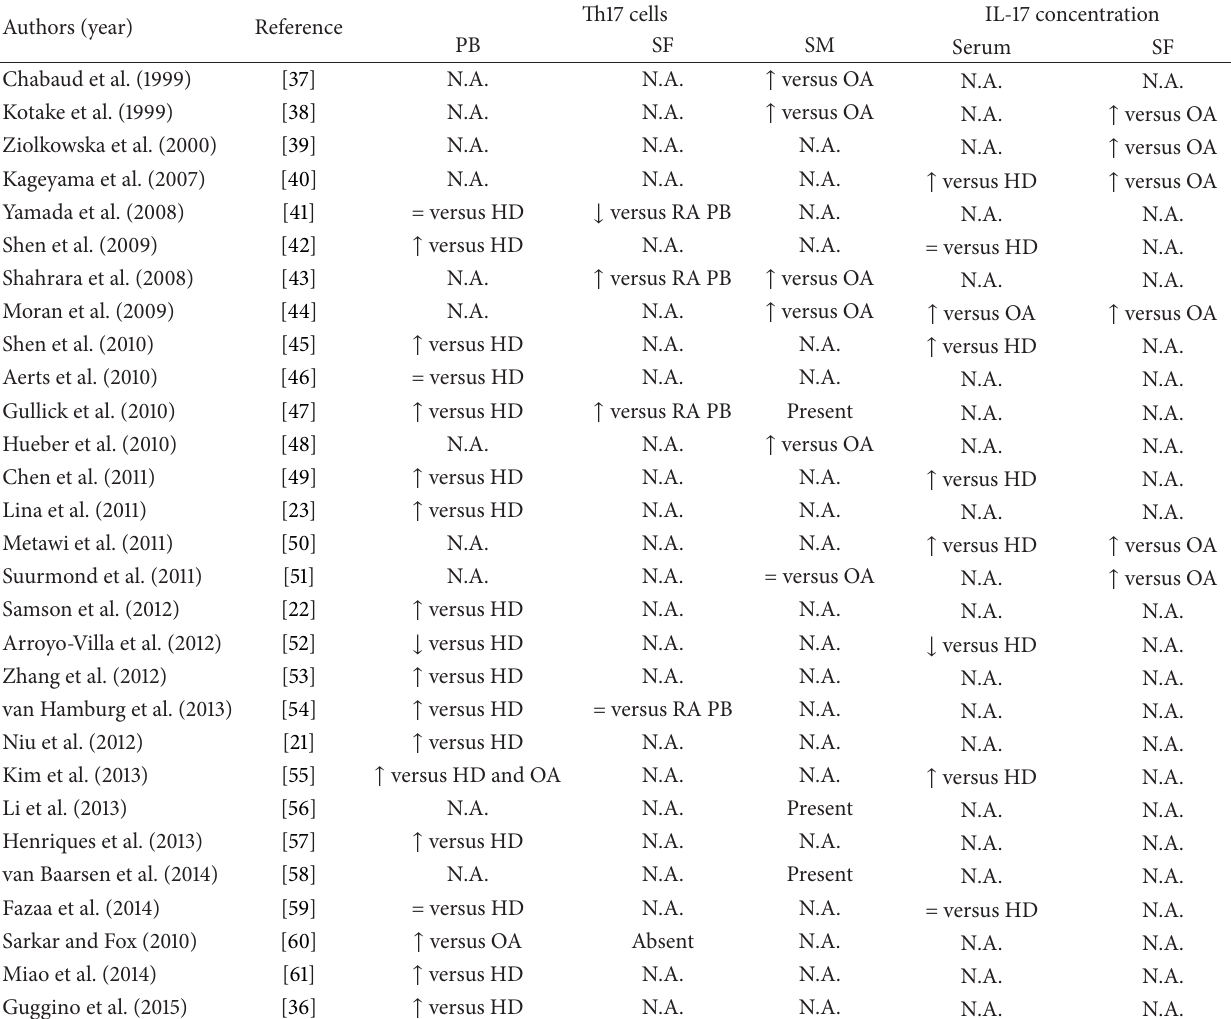
Table 2: Studies assessing Th17 cells and IL-17 in the peripheral blood, synovial fluid, and synovial tissue of patients with rheumatoid arthritis. Authors